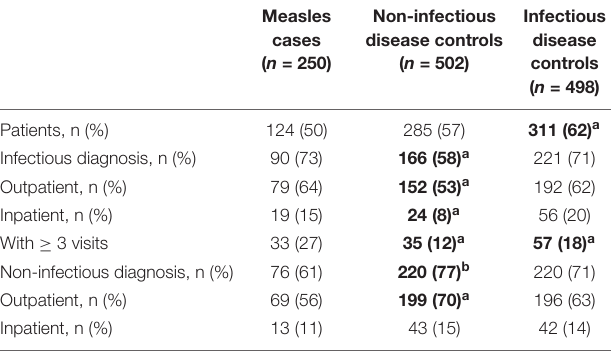
TABLE 2 | Patients with repeat visits to the emergency room.